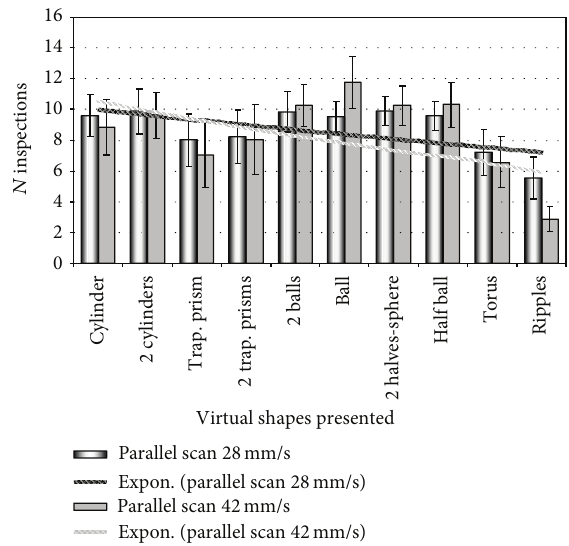
Figure 8: Number of inspections (scanlines) and trend lines of the same shape at the two scanning velocities averaged over all